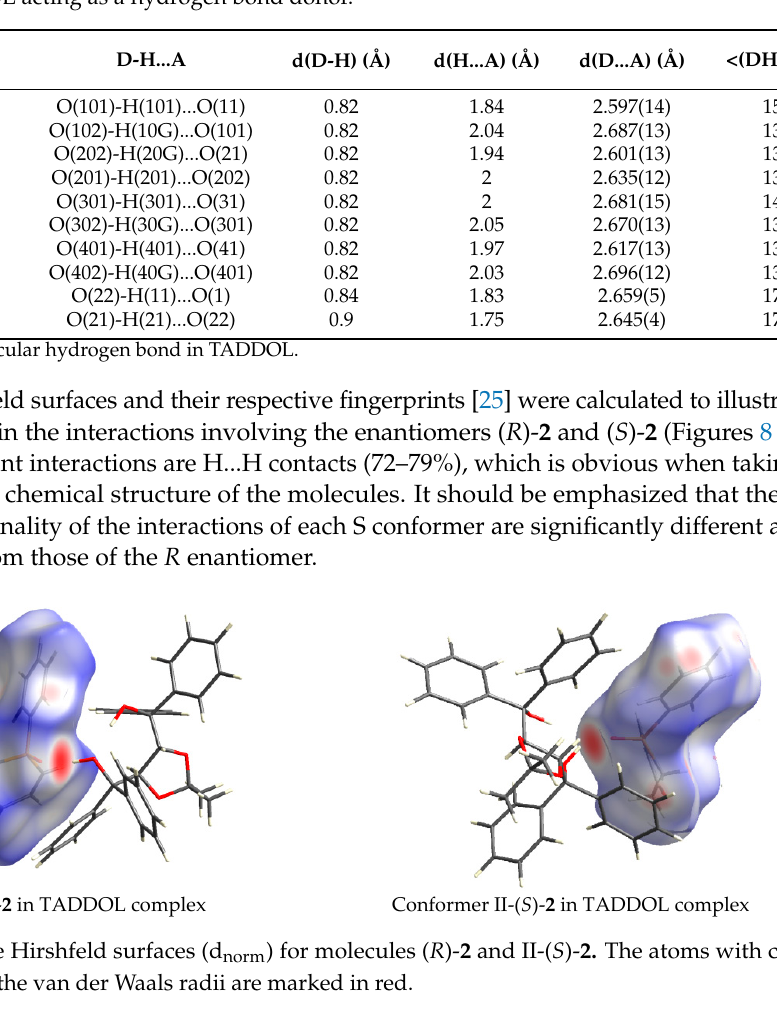
Table 2. Geometry of inter- and intramolecular O-H...O hydrogen bonds in molecular complexes of 2 with TADDOL acting as a hydrogen bond donor.